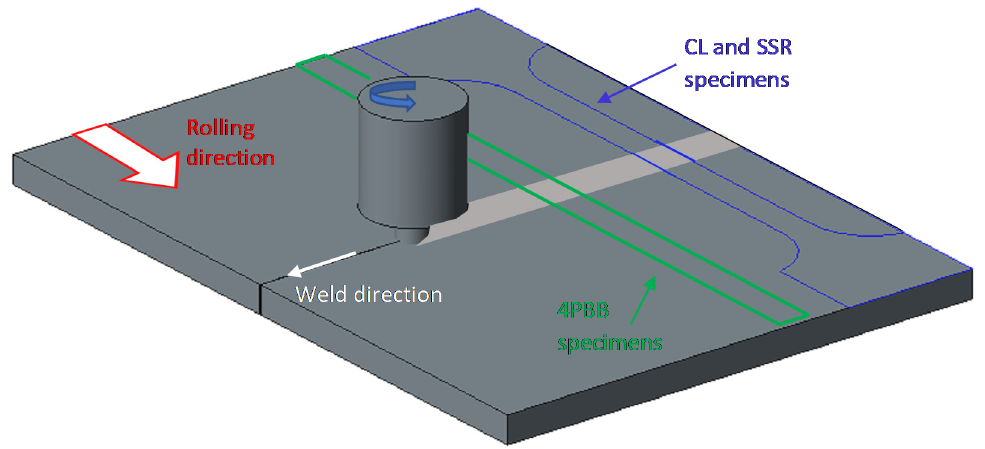
Figure 1. Schematic representation of specimens obtained by means of friction stir welding (FSW) welded sheet (draw not in scale).